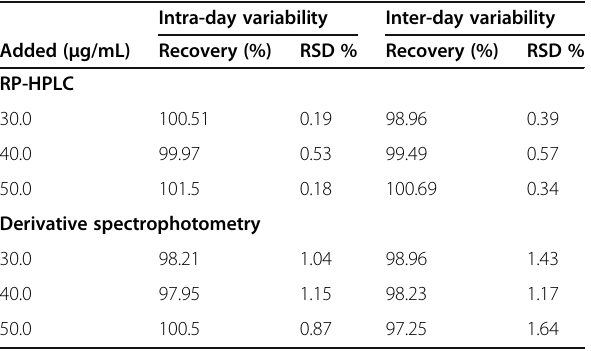
Table 4 Inter-day and Intra-day variability of RP-HPLC for determining VRT concentrations